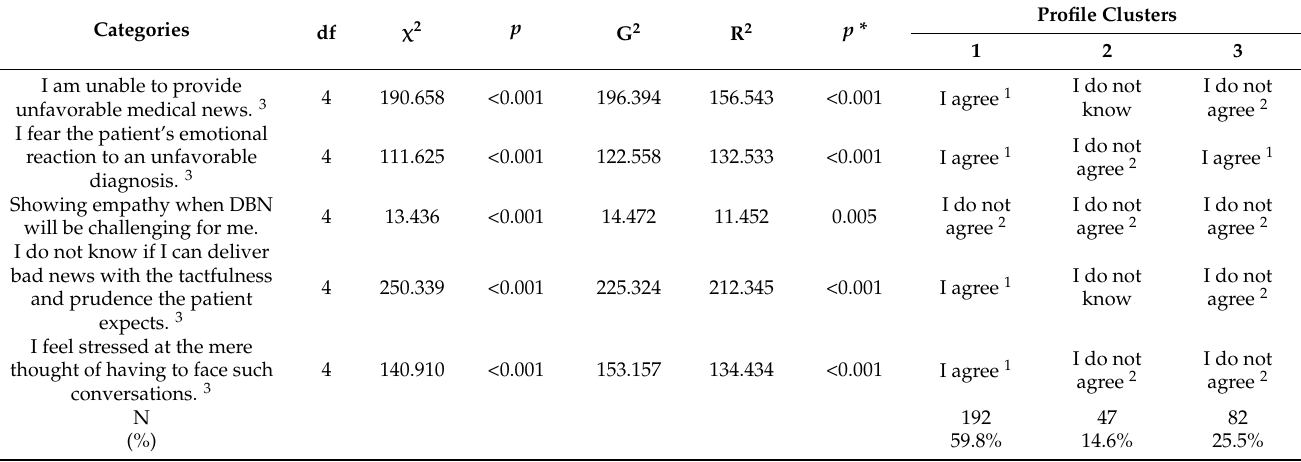
Table 4. Independence test for qualitative variables with profile clusters (N =